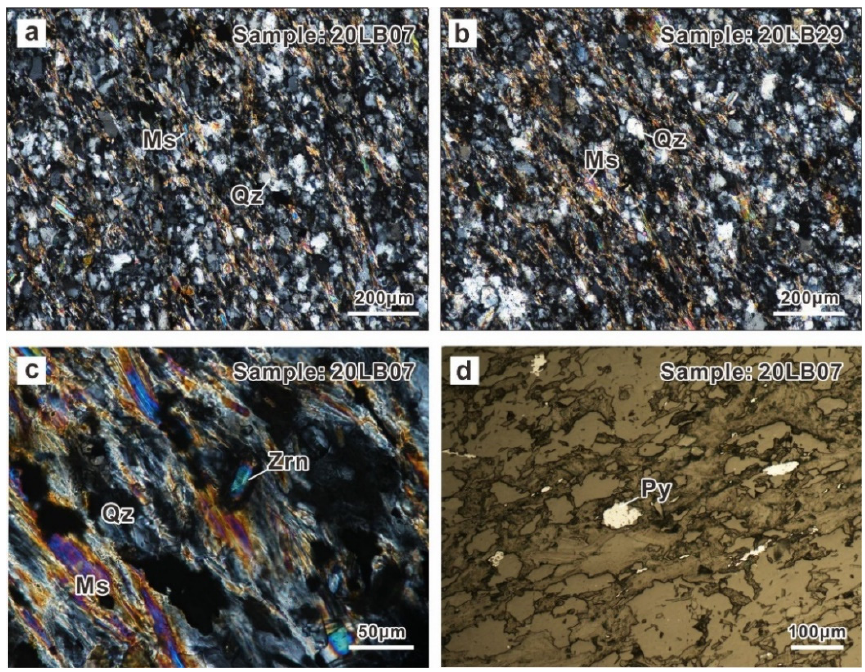
Figure 4. Photomicrographs showing mineral assemblages of the slates. ( a – c ) Transmitted cross-polarized light photomicrographs. ( d ) Reflected light photomicrograph. Ms—muscovite, Qz—quartz, Zrn—zircon, Py—pyrite.